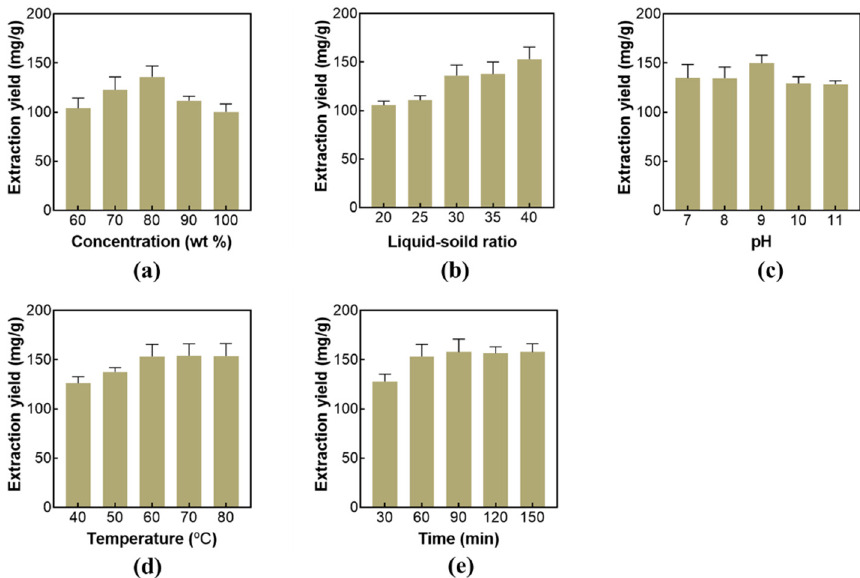
Figure 2. The single-factor experiments of AMP extraction. ( a ) Effect of DESs concentration on AMP extraction. The extraction conditions were as follows: liquid–solid ratio was 30:1, pH was not adjusted, the extraction temperature was 60 °C, and the extraction time was 60 min. ( b ) Effect of the liquid–solid ratio on AMP extraction. The extraction conditions were as follows: DESs concentration was 80 wt%, pH was not adjusted, the extraction temperature was 60 °C, and the extraction time was 60 min. ( c ) Effect of pH on AMP extraction. The extraction conditions were as follows: DESs concentration was 80 wt%, the liquid–solid ratio was 40:1, the extraction temperature was 60 °C, and the extraction time was 60 min. ( d ) Effect of the extraction temperature on AMP extraction. The extraction conditions were as follows: DESs concentration was 80 wt%, the liquid–solid ratio was 40:1, pH was not adjusted, and the extraction time was 60 min. ( e ) Effect of the extraction time on AMP extraction. The extraction conditions were as follows: DES concentration was 80 wt%, the liquid–solid ratio was 40:1, pH was not adjusted, and the extraction temperature was 60 °C.